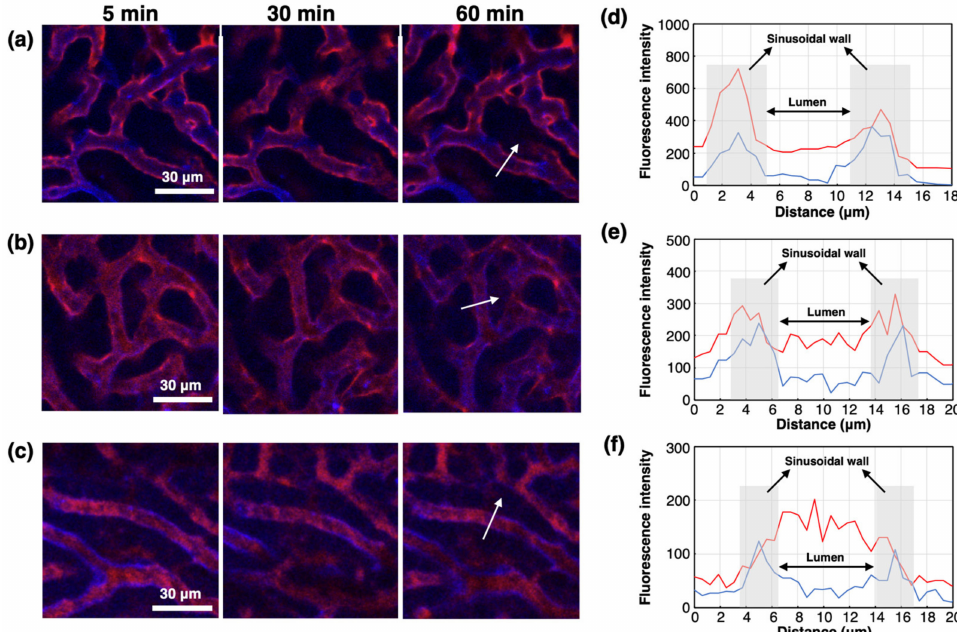
Figure 4. Attachment of Cy5-PIC/m with a C/A of 0.90, 1.00 and 1.10 to the liver sinusoidal wall. IVRT-CLSM images after injection of Cy5-PIC/m (red) with a C/A of ( a ) 0.90, ( b ) 1.00 and ( c ) 1.10. Blue color indicates the liver sinusoidal wall (endothelial cell) stained by eFluor450-PECAM-1. Intensity profiles of Cy5 (red line) and eFluor450 (blue line) in the white arrows in ( a ), ( b ) and ( c ) are shown in ( d ), ( e ) and ( f ), respectively: (d) 0.90; (e) 1.00; (f)